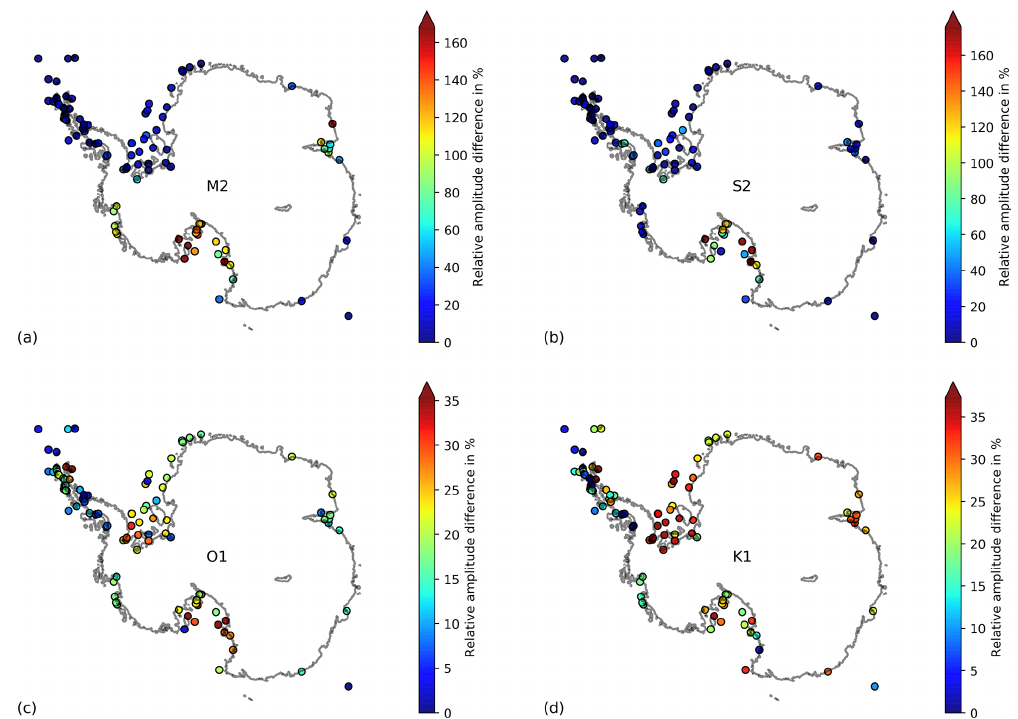
Figure 3. Spatial distributions of tidal height accuracy. Relative amplitude differences between the model solution and Antarctic tide gauge records (cid:0)(cid:2) H WAOM − H ATG (cid:3) /H ATG (cid:1) are shown for the major tidal constituents (a) M2, (b) S2, (c) K1, and (d) O1. The colour bar has been truncated at the 95% quantile.